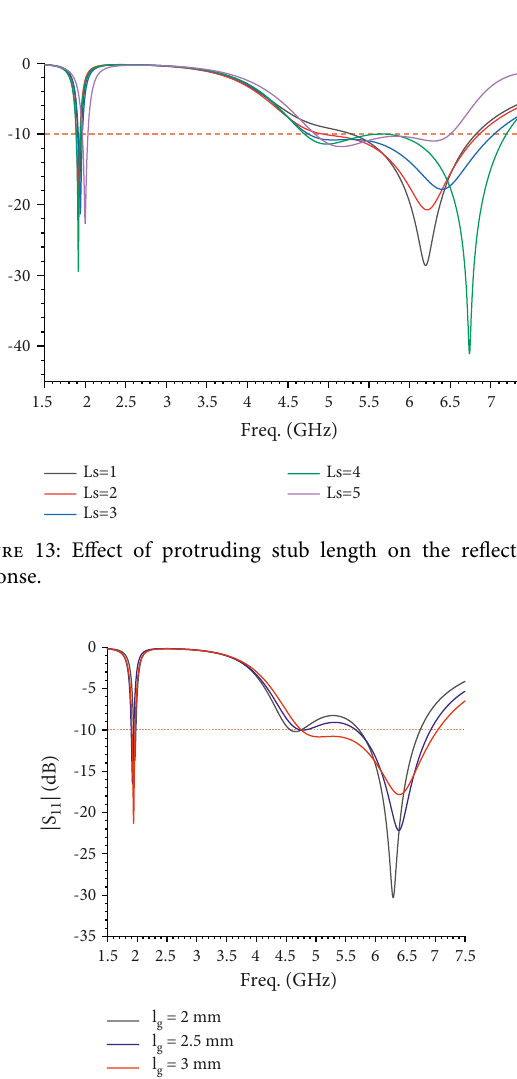
Figure 14: The effect of the ground plane on |S11| response.